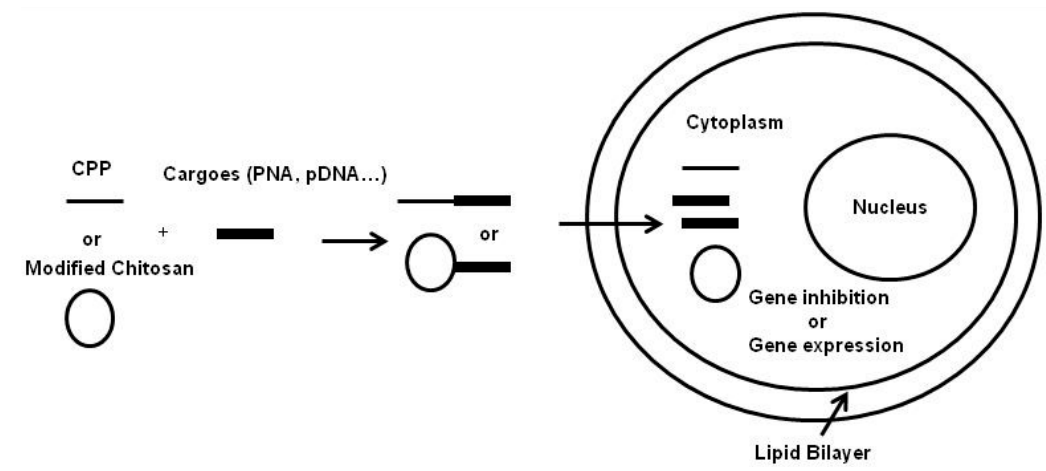
Figure 1. Nonviral gene delivery systems based on CPPs or modified chitosan (CS).